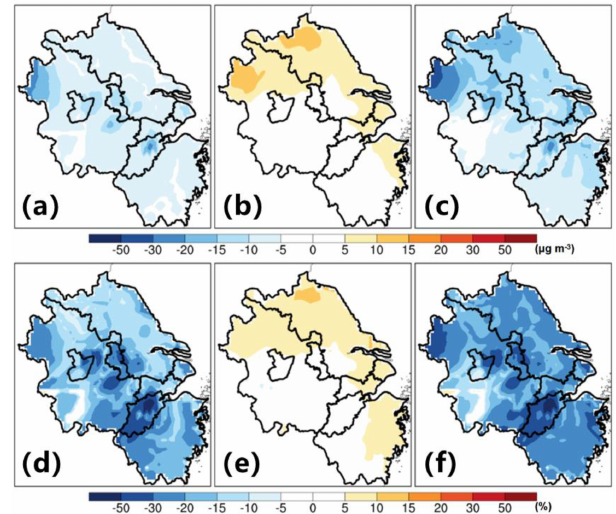
herent biases on spatial PM 2 . 5 concentrations during the G20 sum- mit. (a, d) Their net impacts. (b, e) The impacts of inherent biases. (c, f) The impacts of anthropogenic emission controls. Panels (a) – (c) and (d) – (f) refer to the changes in absolute values and relative percentages, respectively. Inherent biases are mainly due to the prior anthropogenic emissions.